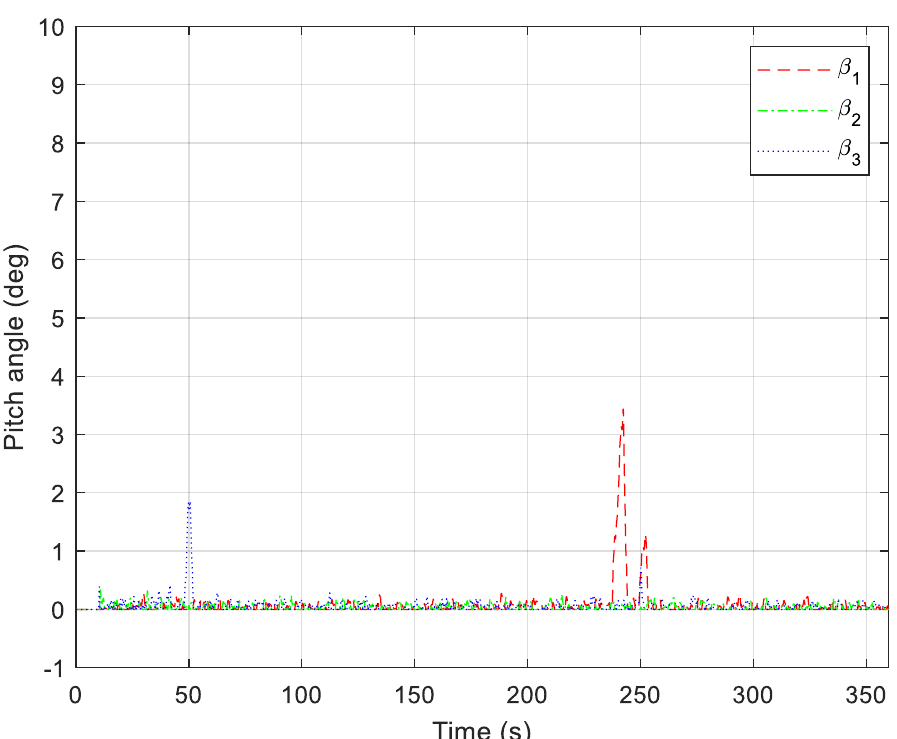
Figure 22. Pitch angles of the wind turbines (random wind disturbance).